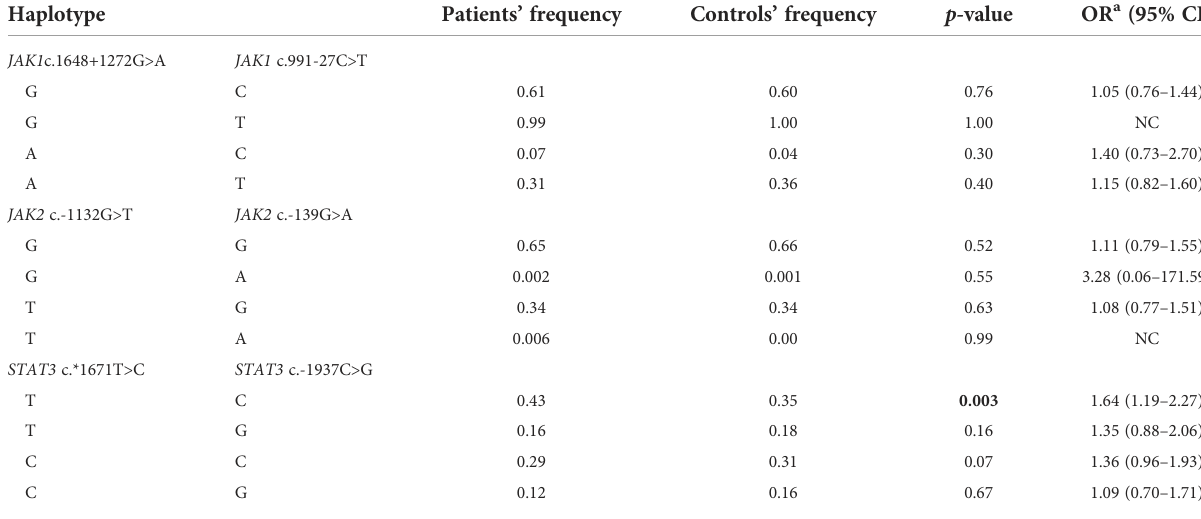
TABLE 4 JAK1 , JAK2 , and STAT3 haplotypes in 248 cutaneous melanoma patients and 274 controls.